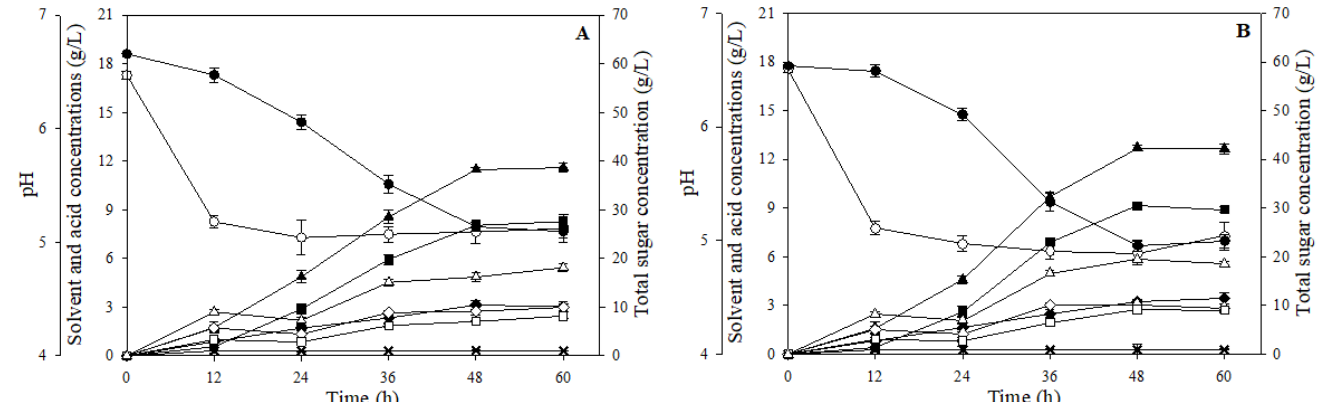
Figure 8. Batch butanol fermentation profiles from SSJ medium supplemented with 0.64 g/L of urea